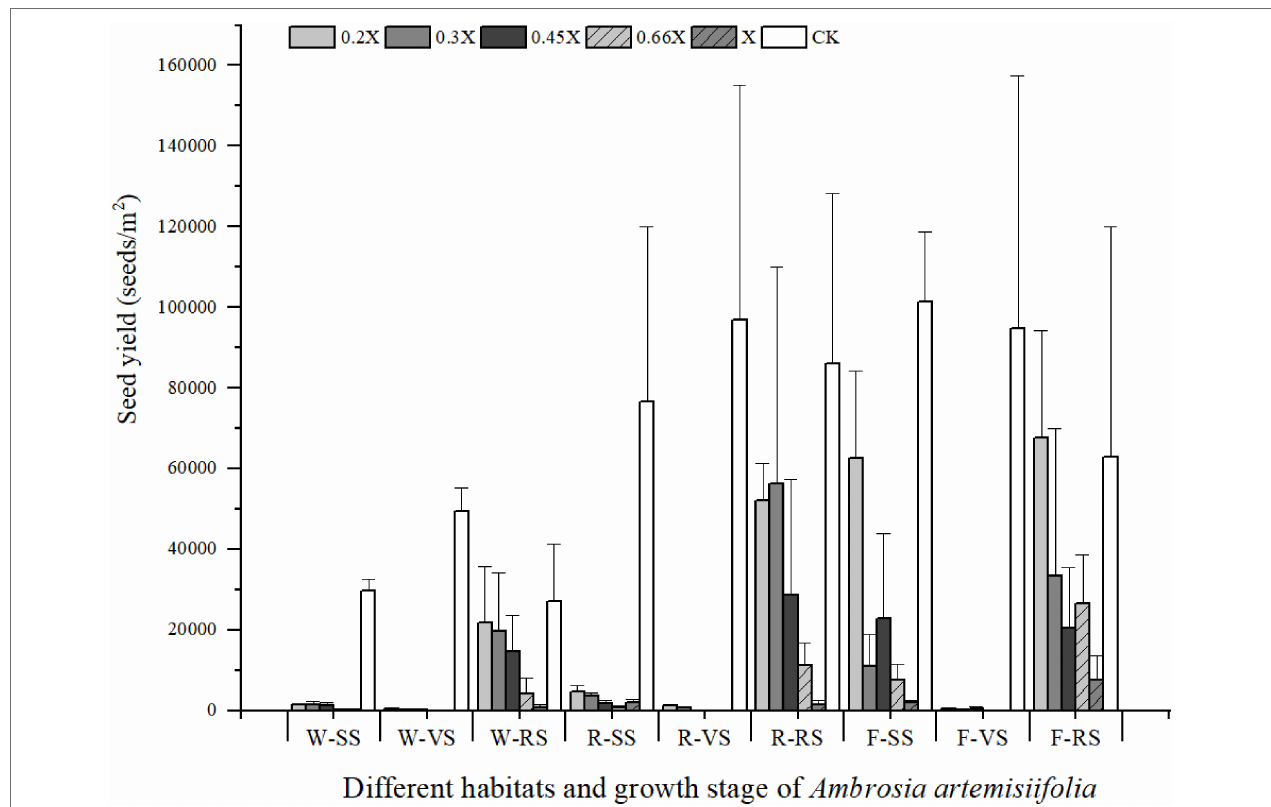
FIGURE 3 | Seed yield of Ambrosia artemisiifolia under different treatments. Three treatments in each habitat occurred at different growth stage of A. artemisiifolia . Habitats and growth stages: W, woodland; R, roadside; F, farmland; SS, seedling stage; VS , vegetative growth stage; RS, reproductive growth stage; and CK, control group. 0.2X, 0.3X, 0.45X, 0.66X, and X represent different doses of aminopyralid. Values are means ±